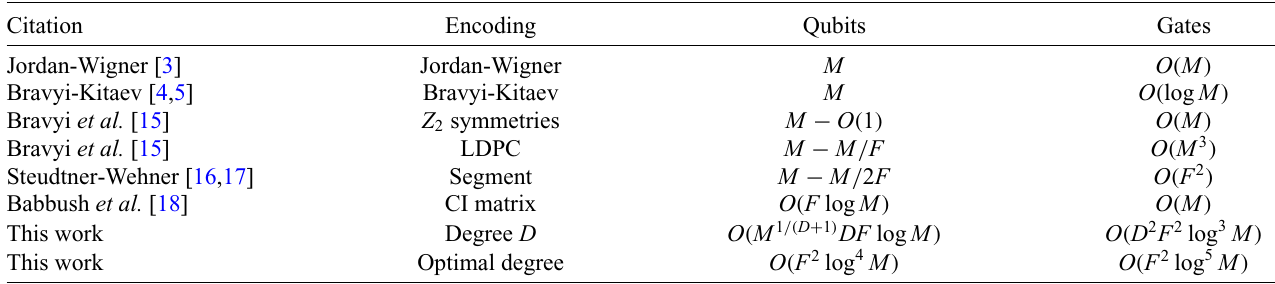
TABLE I. Comparison of this work to prior work on encoding second-quantized fermionic Hamiltonians in qubits. “Gates” refers to the number of one- and two-qubit gates required to implement the encoding of a conjugate pair of fermionic creation and annihilation operators (7). The exception is the CI-matrix encoding in Ref. [18], where “gates” is the cost of the sparse oracle in this sparsity-based approach. The “degree- D code” in this work is parametrized by a positive integer D that we can choose (subject to certain constraints) and that determines the properties of the code as shown. Choosing D to minimize the number of qubits in the M (cid:3) F limit yields the optimal-degree